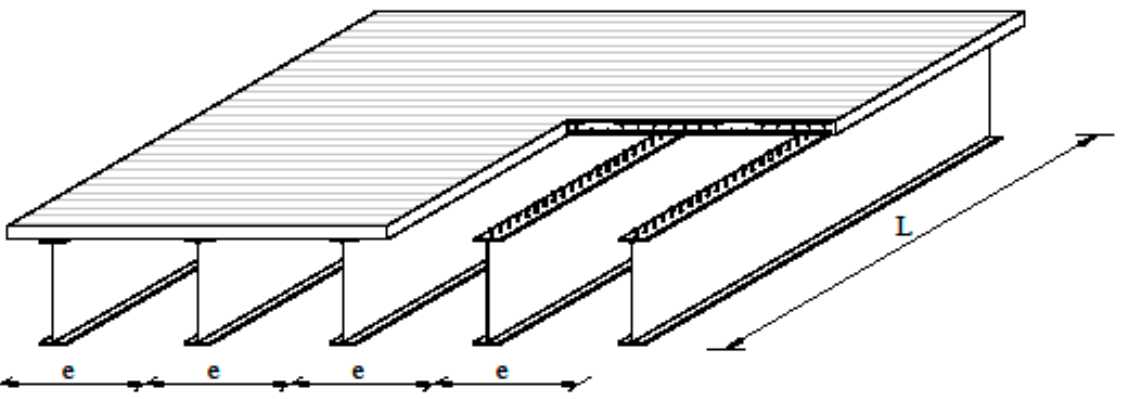
Figure 1. Steel–concrete composite I-beam floor system.